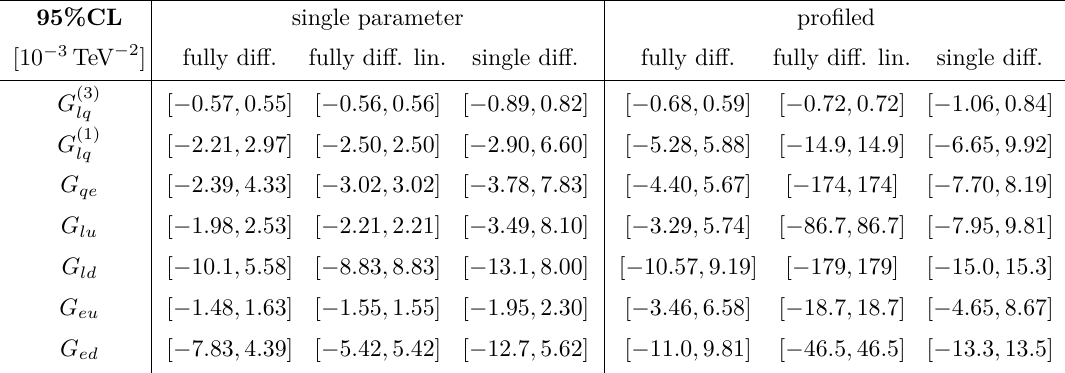
Table 5 . 95% CL projected bounds for the four-fermion operator coefficients in the Warsaw basis, including a 2% uncorrelated systematic